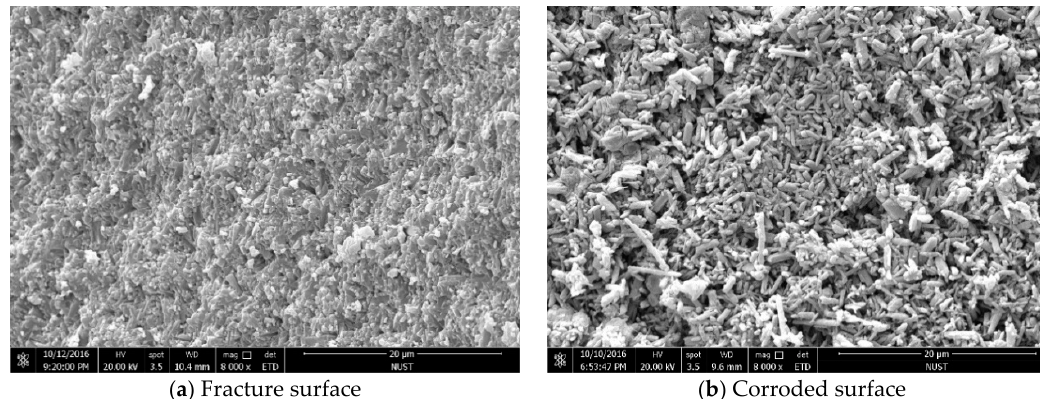
Figure 7. SEM micrographs of fracture surface morphology of the Si 3 N 4 material (0 wt%) at 1600 °C for 10 min.